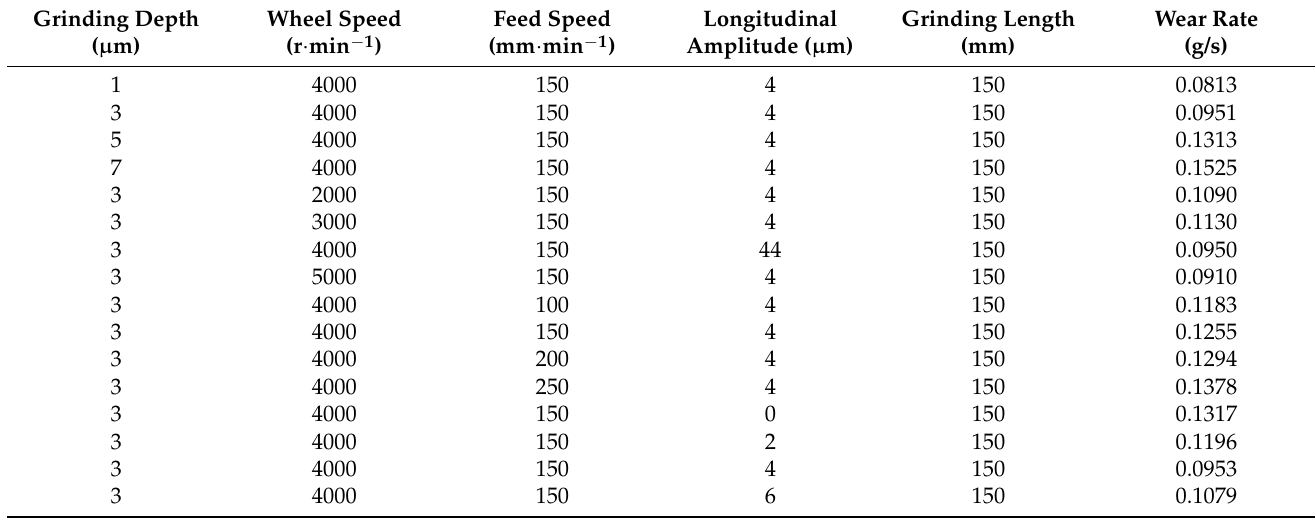
Table 6. Single-factor experimental results of grinding wheel wear rate in LTUAG of TC4 titanium